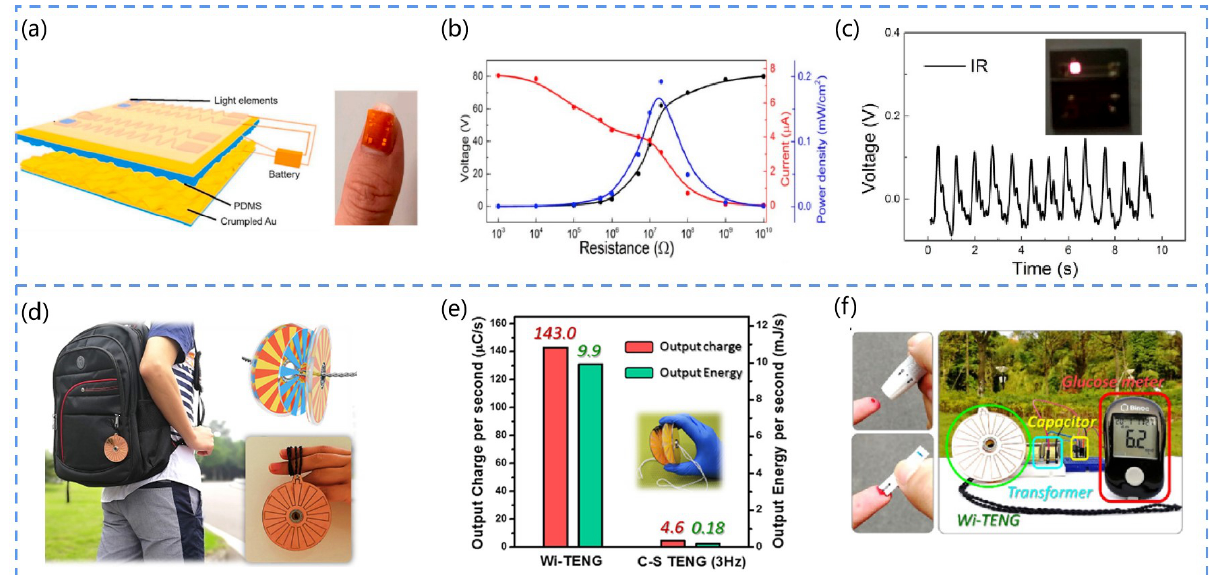
Figure 7. ( a ) Schematic diagram of the structure of the TENG and the monitoring of blood oxygen. ( b ) TENG output performance voltage and output power density. ( c ) PPG signal of the oximeter. Reprinted from [60] with permission from MDPI. ( d ) Schematic diagram of the structure of the rotating TENG. ( e ) Schematic diagram comparing the output of the CS-TENG and the Wi-TENG. ( f ) Schematic diagram of a self-powered glucose monitoring system. Reprinted from [61] with permission from